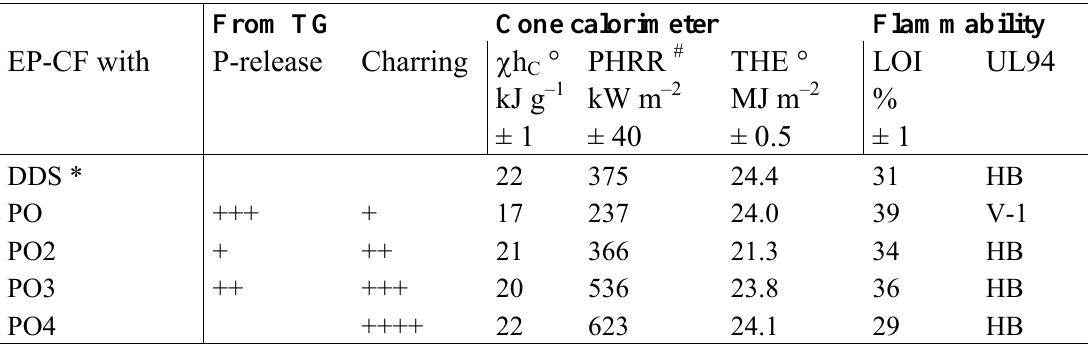
Table 5. Propensity for phosphorus release and charring determined for the EP by thermal analysis, combustion efficiency multiplied by the effective heat of combustion ( χ⋅ h PHRR and THE determined by cone calorimeter and flammability (LOI, UL 94) for the composites (60 vol.-% carbon fibers); phosphorus content in the EP-CF is around 1 wt.-% (with respect to the EP = ~2.6